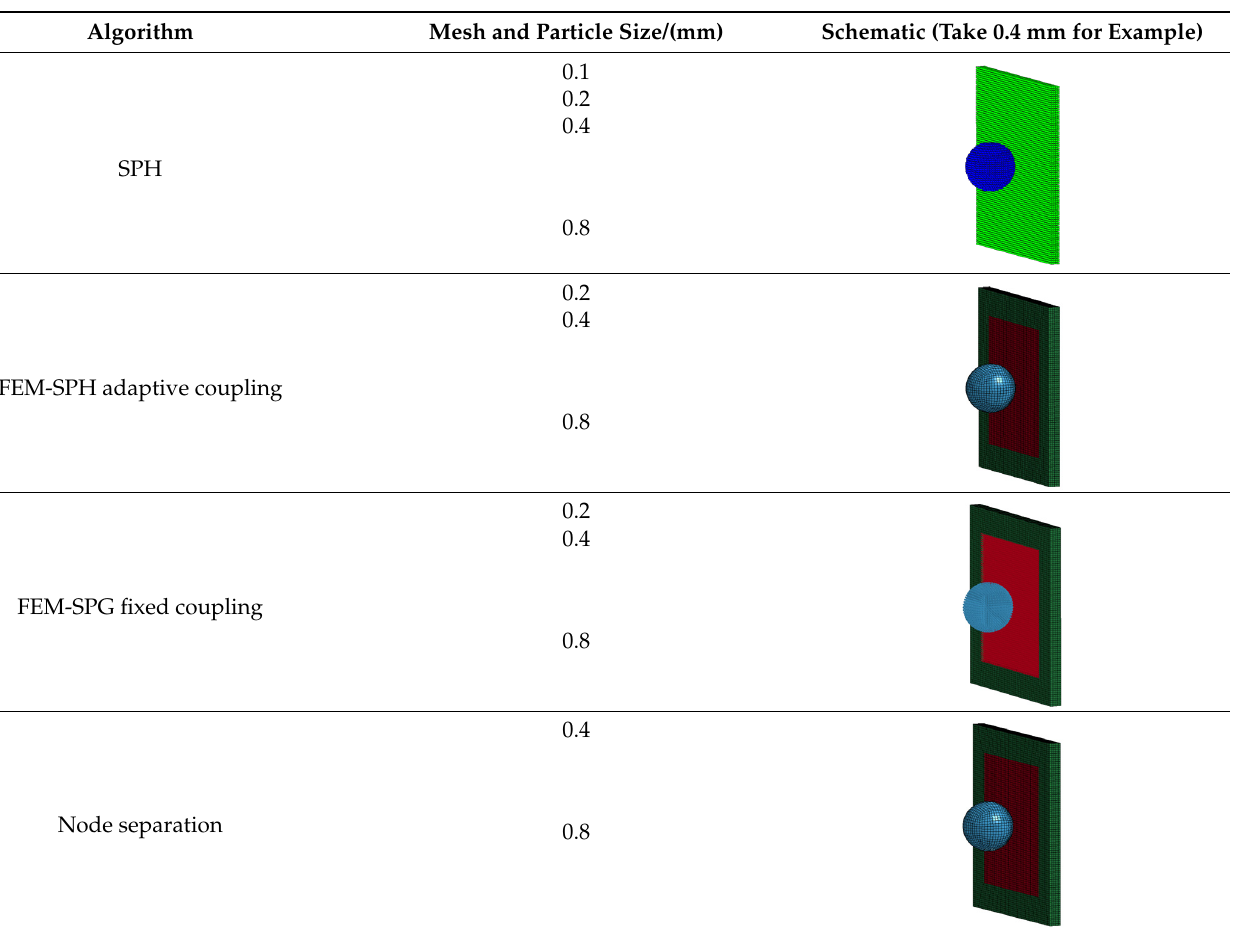
Table 3. Simulation conditions.